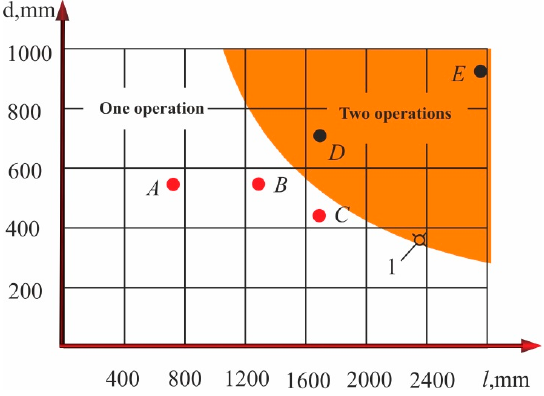
Figure 11. Dependence of the optimal number of finishing operations of grinding rolls to obtain a surface roughness of 𝑅𝑎 = 0.04 –0.02 µm .